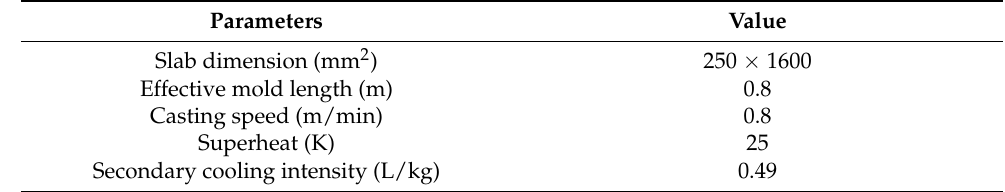
Table 2. The continuous casting process parameters used during sampling.